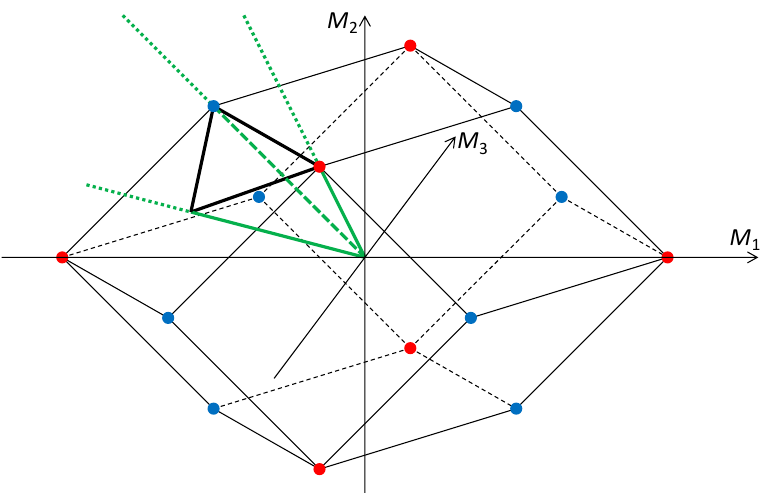
Figure 4 . The fundamental domain in the B 3 Weyl chamber (2.8) (surrounded by green